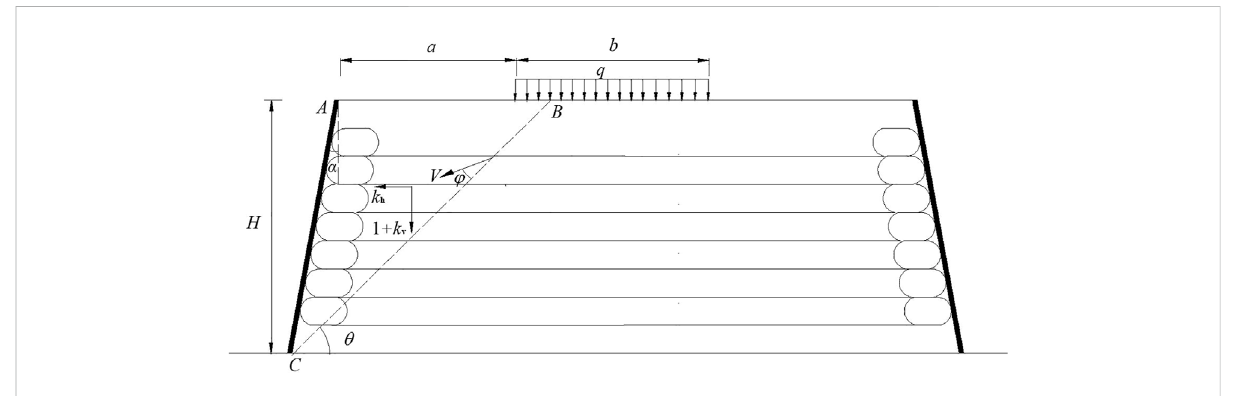
FIGURE 1 Analysis model of planar failure